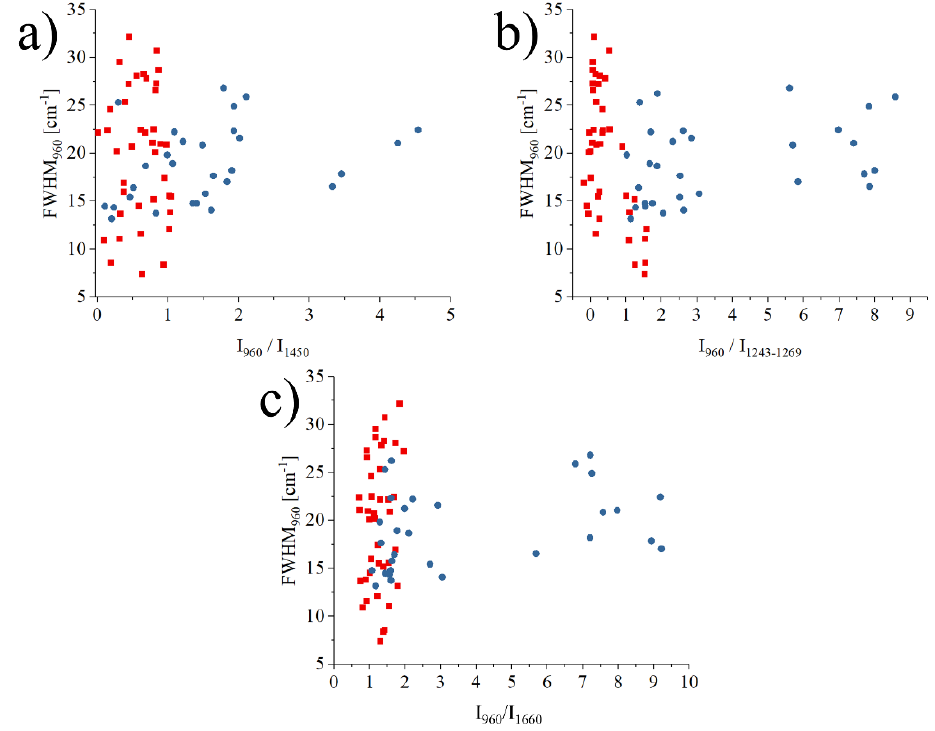
Figure 5. Graphs ( a – c ) of the relationship between the each of intensity ratio I960cm − 1 /I1450cm − 1 , I960cm − 1 /I1243–1269cm − 1 , I960cm − 1 /I1660cm − 1 and FWHM of the band located at 960 cm − 1 . Different trends between alcoholic necrosis and steroidal necrosis regions are shown.